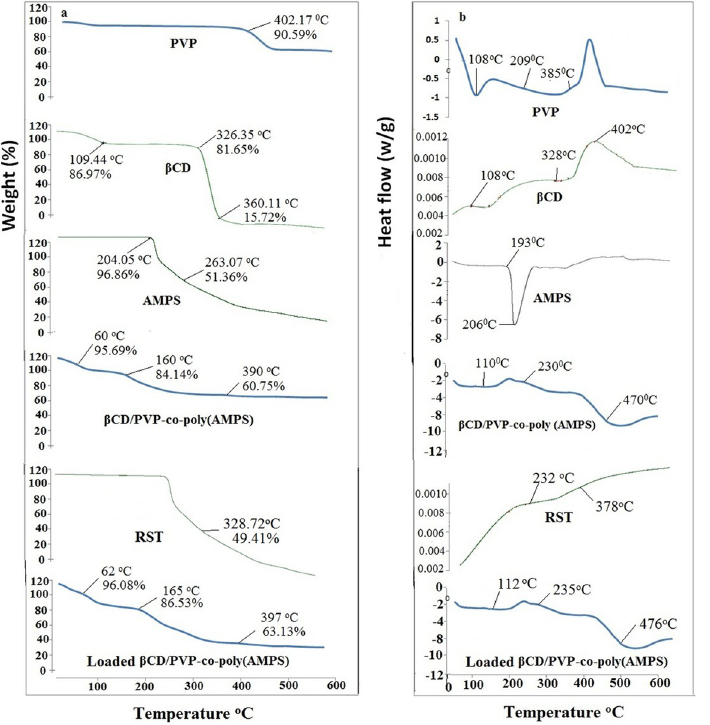
Fig 5. TGA thermogram (a) and DSC curve (b) of β CD, PVP, AMPS, RST, unloaded and RST loaded β CD/PVP-co- poly (AMPS) nanogels indicating better thermal stability of nanogels than individual components.